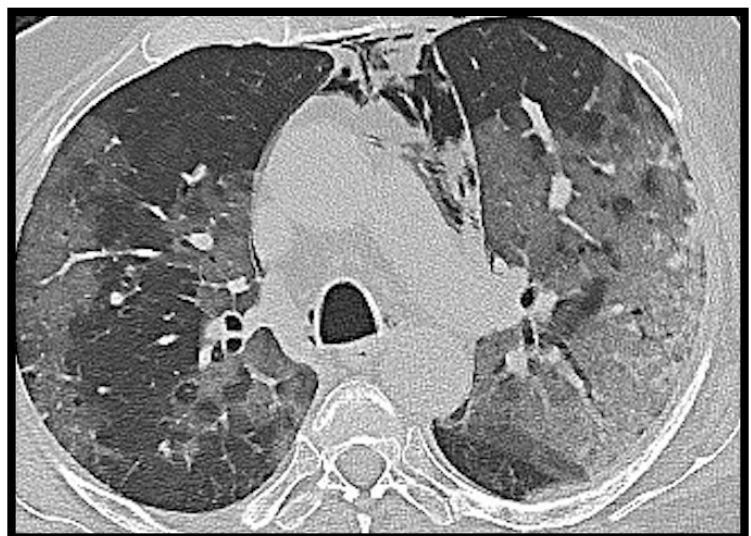
Figure 1. Computed tomography (CT) axial image of ground glass opacity. A hospitalized COVID- 19 patient with fever and dyspnea. The axial CT image shows bilateral ground glass opacities with peripheral subpleural disposition in the right lung and tending to confluence in the left lung. Spontaneous pneumomediastinum is